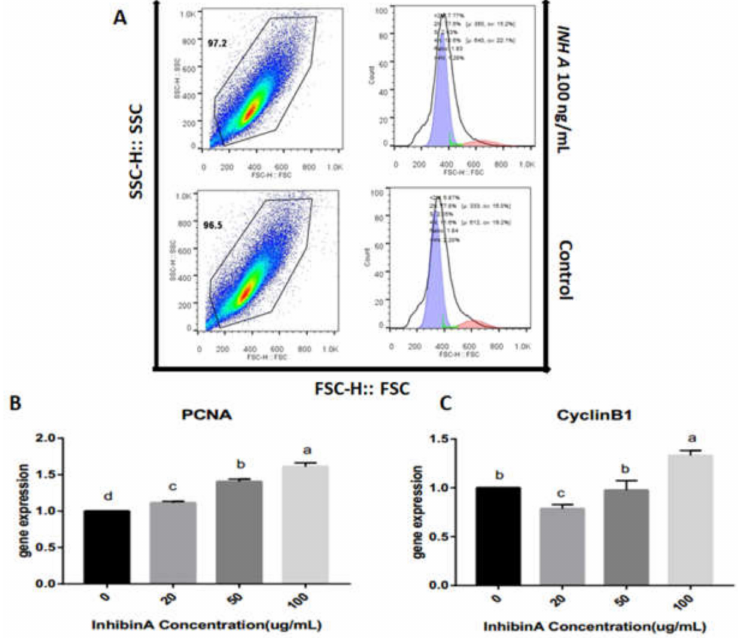
Figure 5. Inhibin A alters the stages of GCs cycle: Flow cytometric analysis of GCs cultured under the treatment of inhibin A (100 ng / mL) and the corresponding control group. The Y axis shows the analyzed cell counts while the X axis indicates the DNA content of cells stained by PI staining ( A ). mRNA expression of PCNA ( B ) and CyclineB1 ( C ) in GCs cultured under di ff erent concentrations of inhibin A (20, 50, and 100 ng / mL) and the corresponding control (0 ng / mL). GADPH was used as a reference gene. The results are expressed as the mean ± SEM, n = 3. The bars labeled with completely di ff erent letters indicate a significant di ff erence, p <